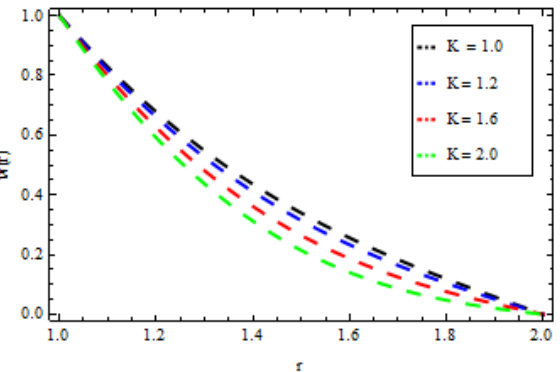
Figure 7. Velocity profile for various values of K when δ = 2, β = 0.2, M =